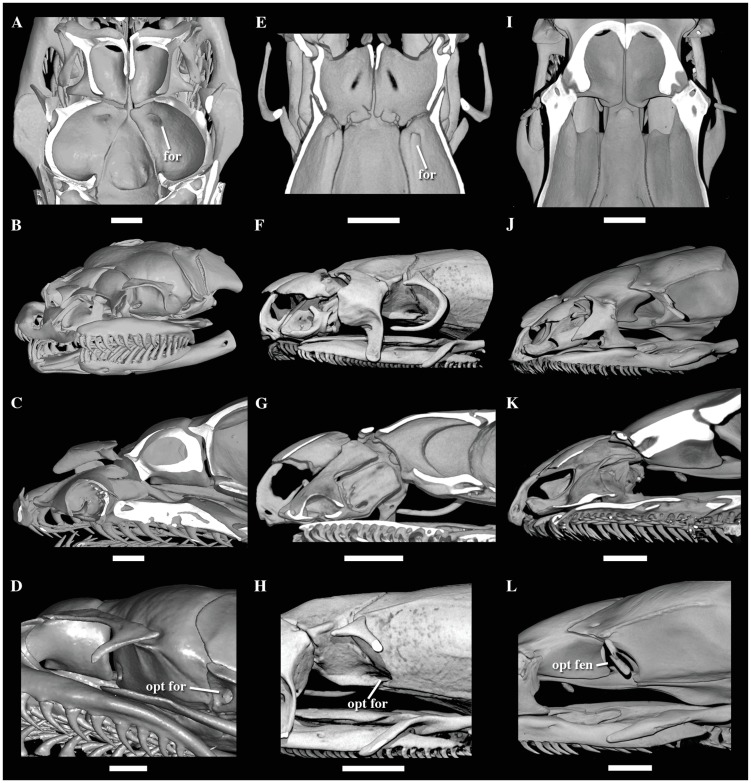
Skulls of Acrochordus granulatus (A-D),
Fimbrios klossi (E-H), and Xylophis
perroteti (I-L).Three-dimensional surface and cutaway views based on high resolution
X-ray computed tomography. A, E, I, dorsal three-dimensional cutaway
views along the frontal axis; B, F, J, oblique three-dimensional
surface views; C, G, K, left lateral three-dimensional cutaway views
along the sagittal axis; D, H, L, left lateral three-dimensional
surface views. Legends: for., optic foramina;
opt. fen., optic fenestra.
Scale bar = 1mm.